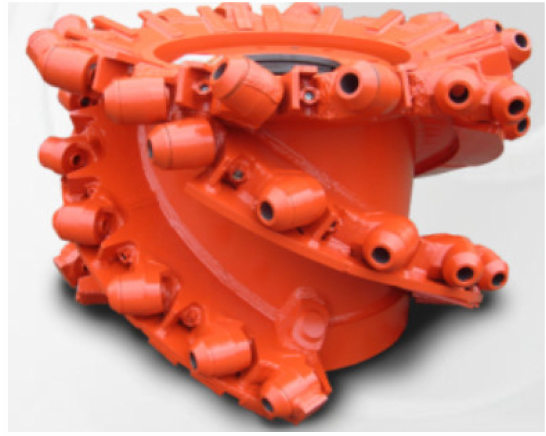
Figure 2. Cutter drum of the shearer